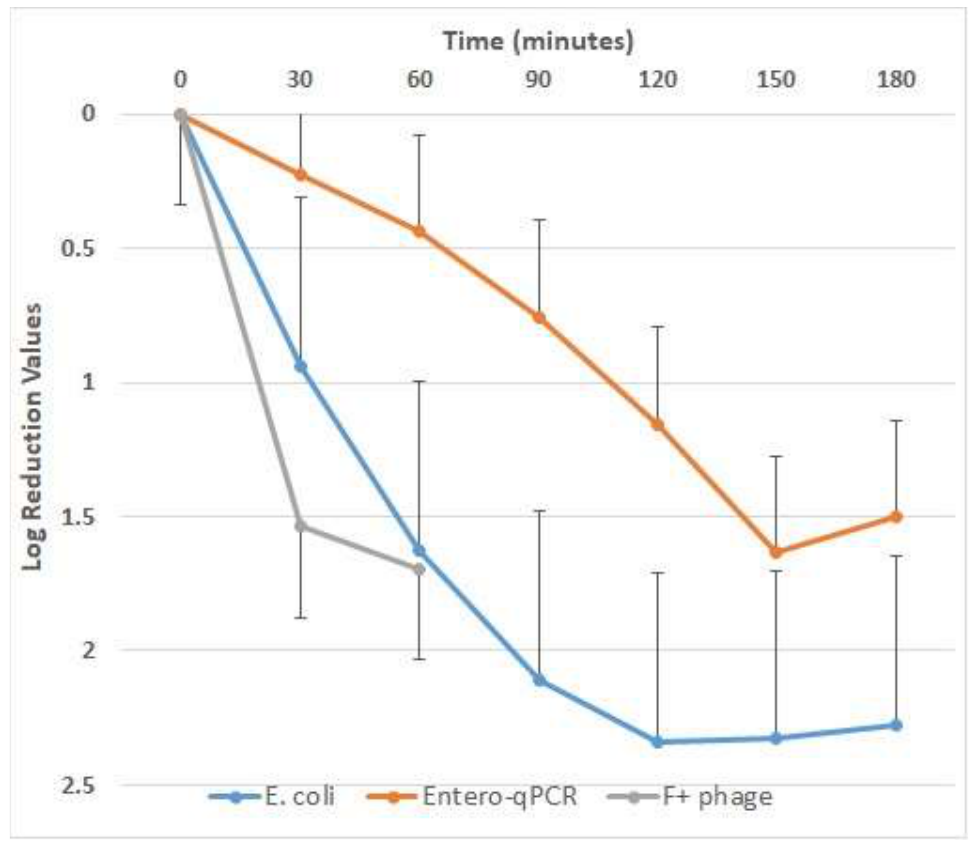
Figure 2. Changes in indicator microbe concentration in wastewater, as log removal value (LRV) following ozonation. Error bars (up-going or down-going) indicate standard deviation across all trials for each indicator microbe.